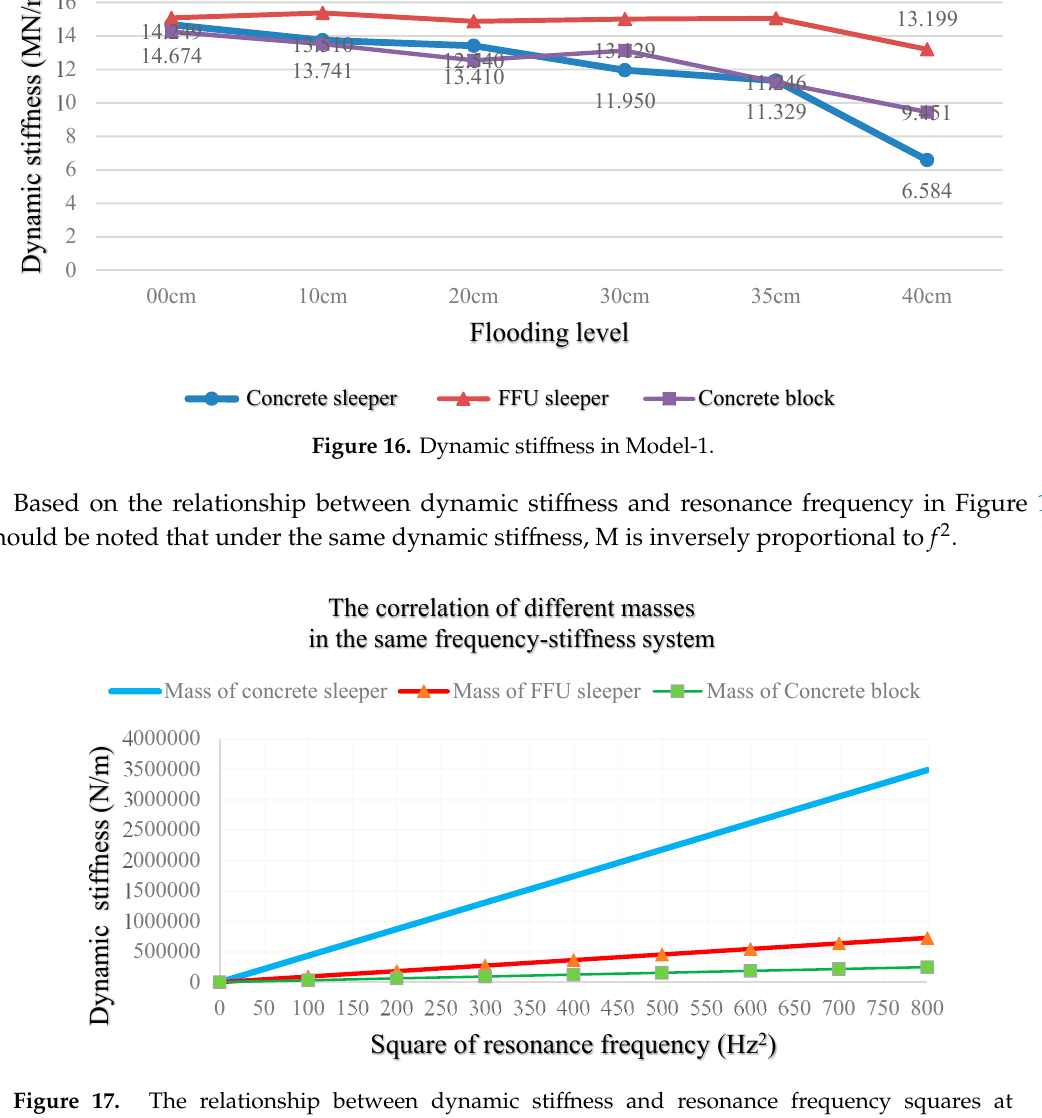
Figure 17. The relationship between dynamic sti ff ness and resonance frequency squares at di ff erent